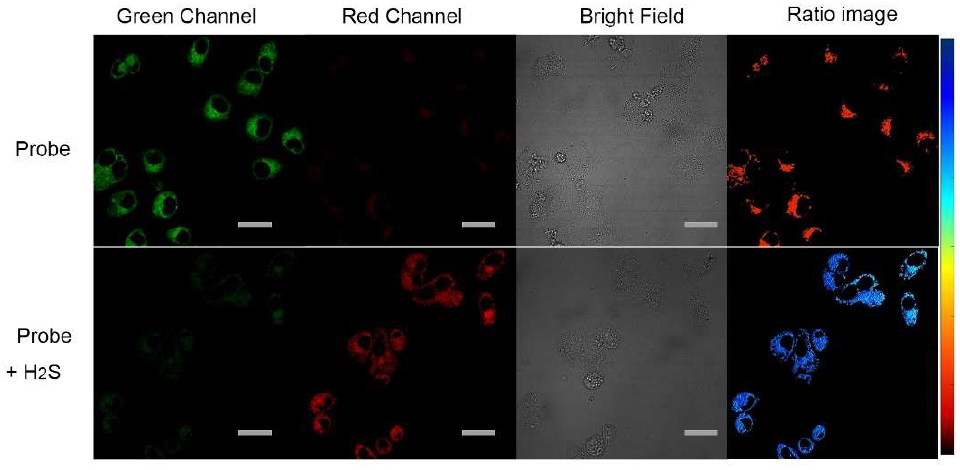
Figure 6. Confocal fluorescence images of Hela cells incubated with probe BH (5 μM) in the absence and presence of H 2 S (300 μM). The ratio image is based on the red channel divided by the green channel. Scale bar: 20 μm.